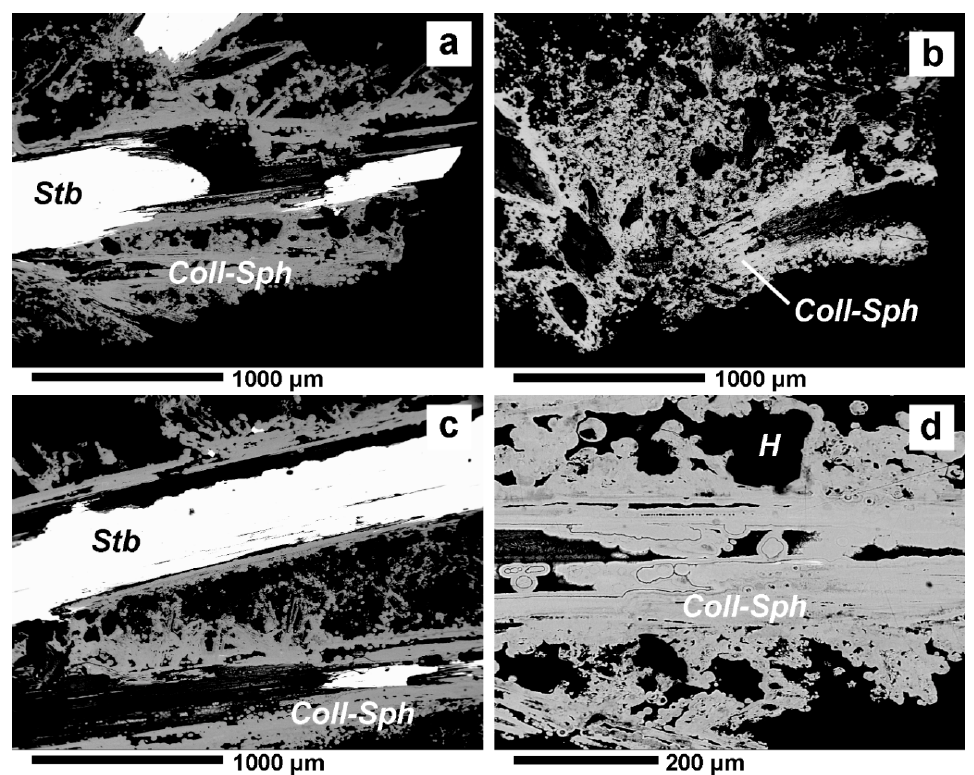
Figure 8. BSE images showing specific fabric of colloform sphalerite: ( a,c ) alternating bands of colloform sphalerite (Coll-Sph) associated with stibnite (Stb); ( b ) earthy aggregates with high porosity; ( d ) nodules and holes (H) between laminated colloform sphalerite.